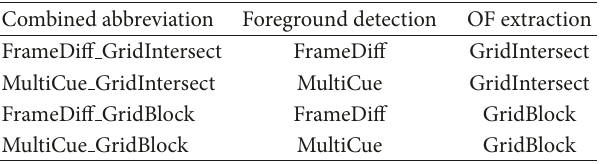
Table 3: Combined methods constructed from all foreground detection and OF extraction